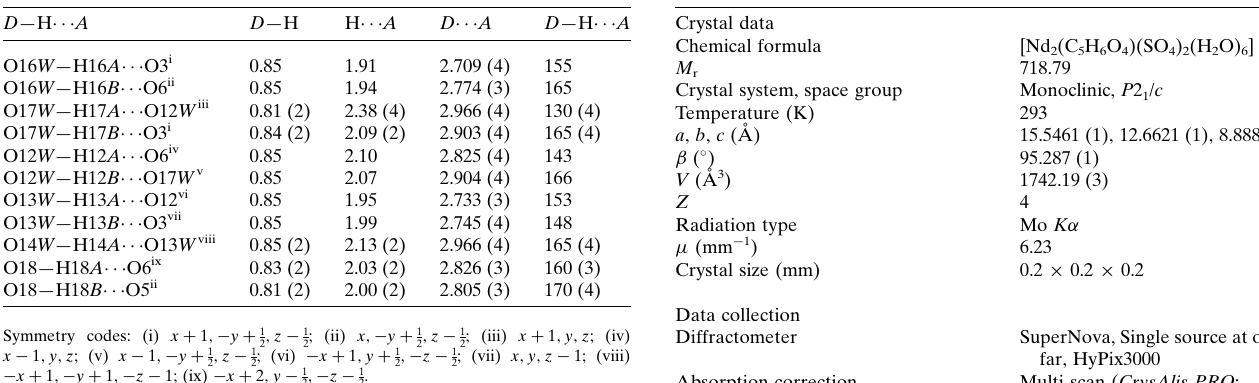
Table 1 Hydrogen-bond geometry (A˚ , (cid:4) ).